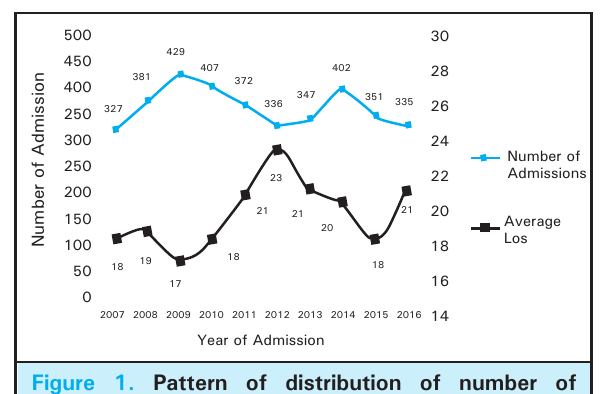
Figure 1. Pattern of distribution of number of admissions and average length of stay according to